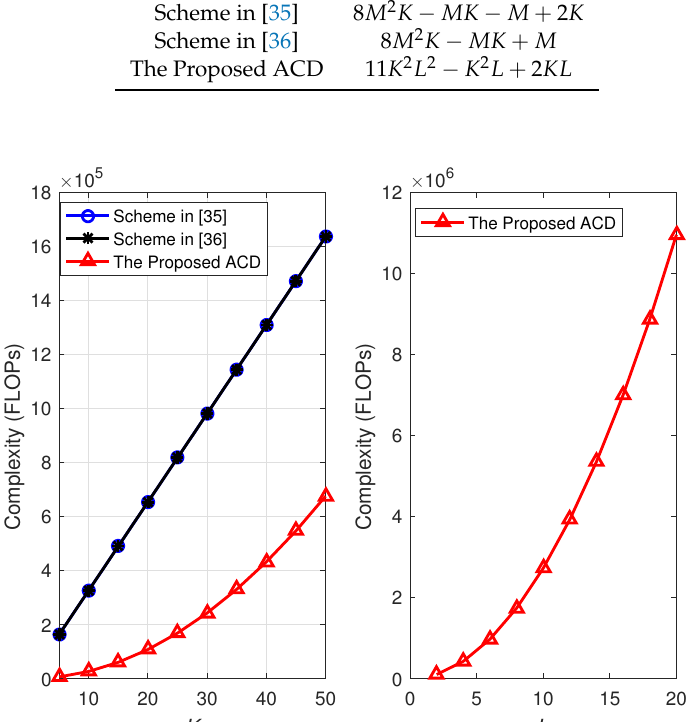
Figure 3. Computational complexity comparison between the proposed ACD and those in